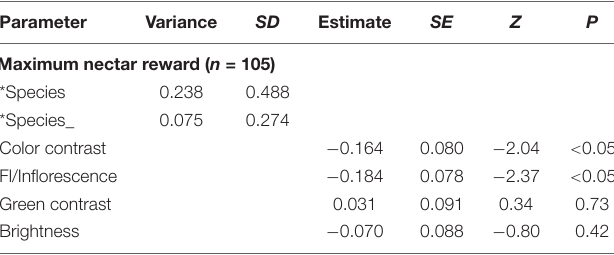
TABLE 3 | PGLMM for maximum nectar reward data of single open